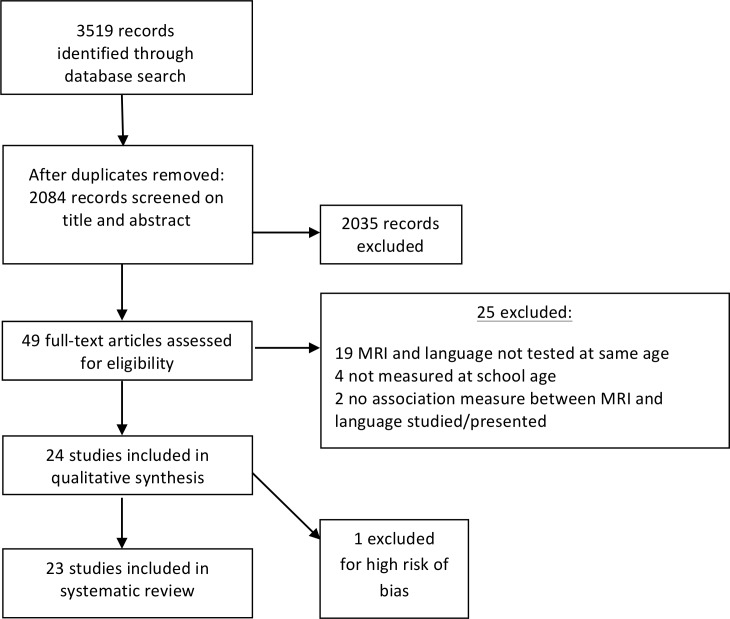
Flow diagram of study selection.